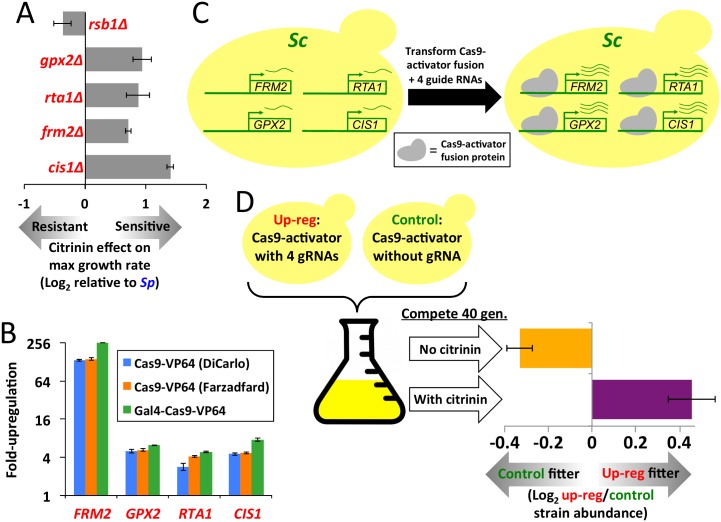
Effects of candidate gene deletion and over-expression.
A. The five candidate genes were deleted from Sp, and the effect on resistance to 300 ppm citrinin was measured. Four deletions increased sensitivity (t-test p < 0.005 for each), and were studied further. Error bars show 1 S.E. B. The effects of three different dCas9 fusion proteins targeted to four candidate genes were measured by qPCR. C. Illustration of our strategy to over-express four genes via dCas9 fusion protein. D. We used direct competition for 40 generations to measure the relative fitness of the four-gene over-expression strain (with a Gal4-dCas9-VP64 dual fusion) vs. a control strain containing the same plasmid, but lacking any gRNAs. Conditions were YPD, and YPD + 300 ppm citrinin. Error bars show 1 S.E.